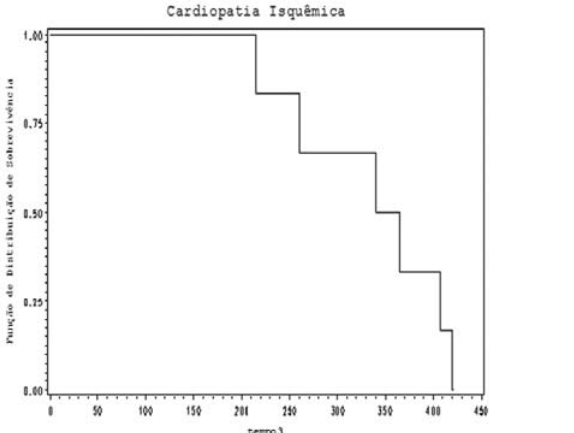
Fig. 5 - Sobrevivência por Tipo: Cardiopatia Isquêmica - tempo 3: T3 - Tempo da Presença do Doente na Sala de Operação (minutos)